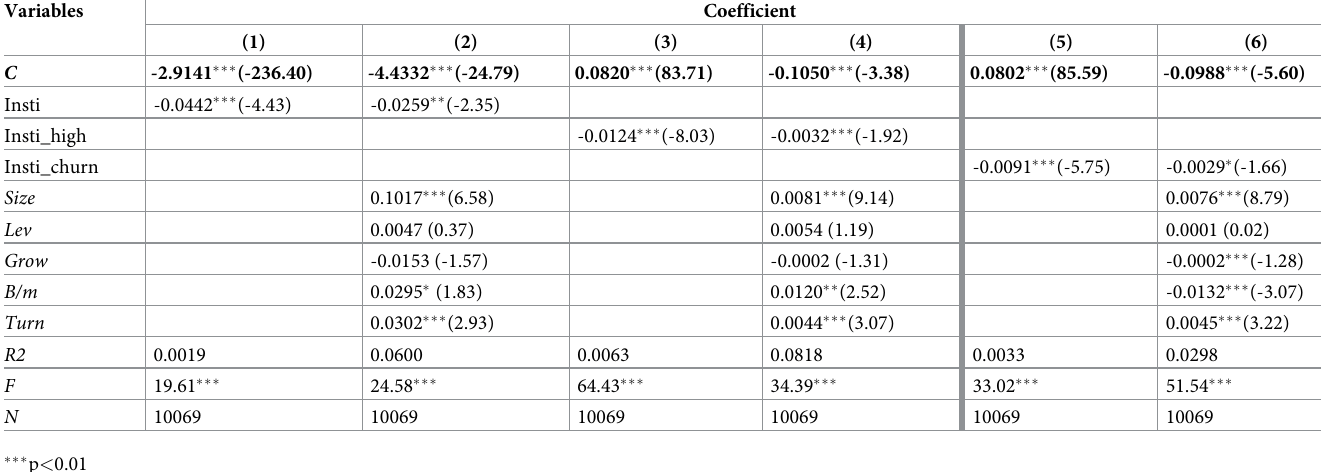
Table 3. The effect of institutional investor on the cost of capital.